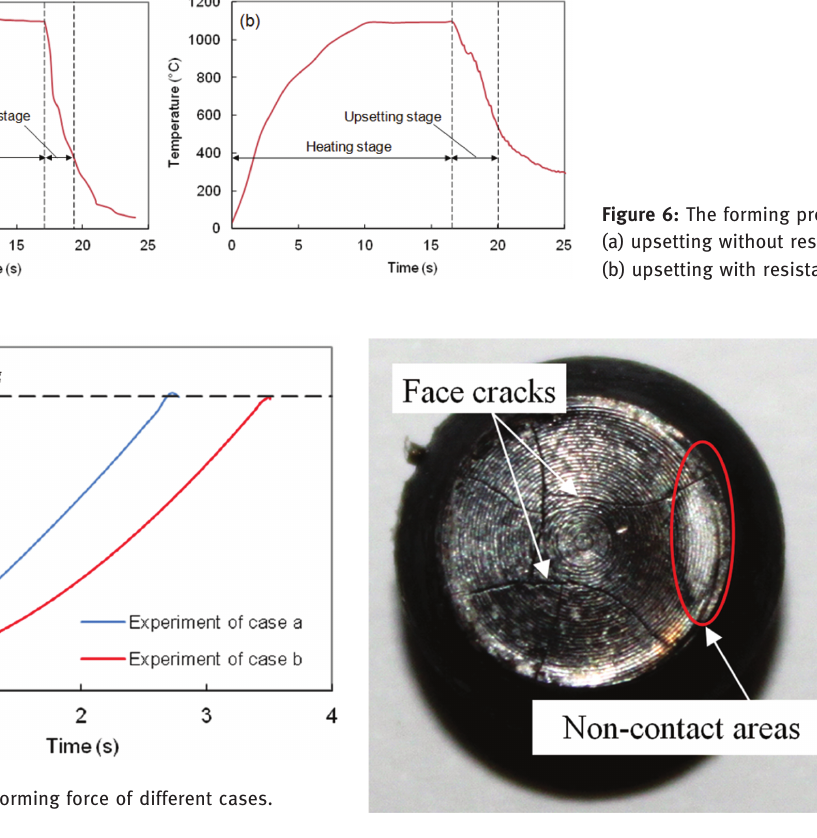
Figure 8: The billet face quality in the experiment of case b.